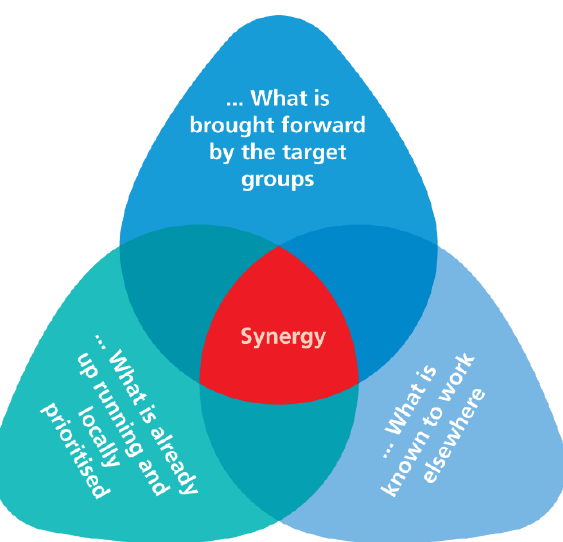
Figure 3. The development of activities was based on a balance between what was brought forward by the participating groups, what was known to work elsewhere, and what was already up running and prioritized locally. Activities that encompassed all three spheres provided maximal synergy and, thereby, impact.